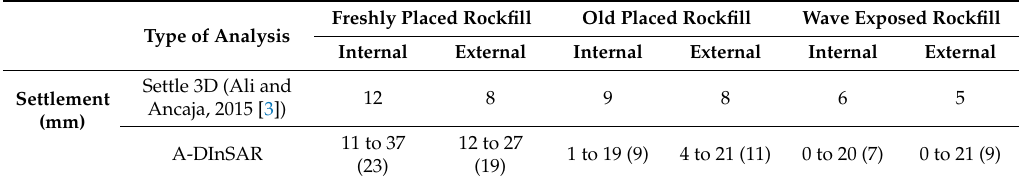
Table 7. Summary of creep settlement results (predicted versus measured) from September 2012 to October 2016. Freshly Placed Rockfill Old Placed Rockfill Wave Exposed Rockfill Type of Analysis